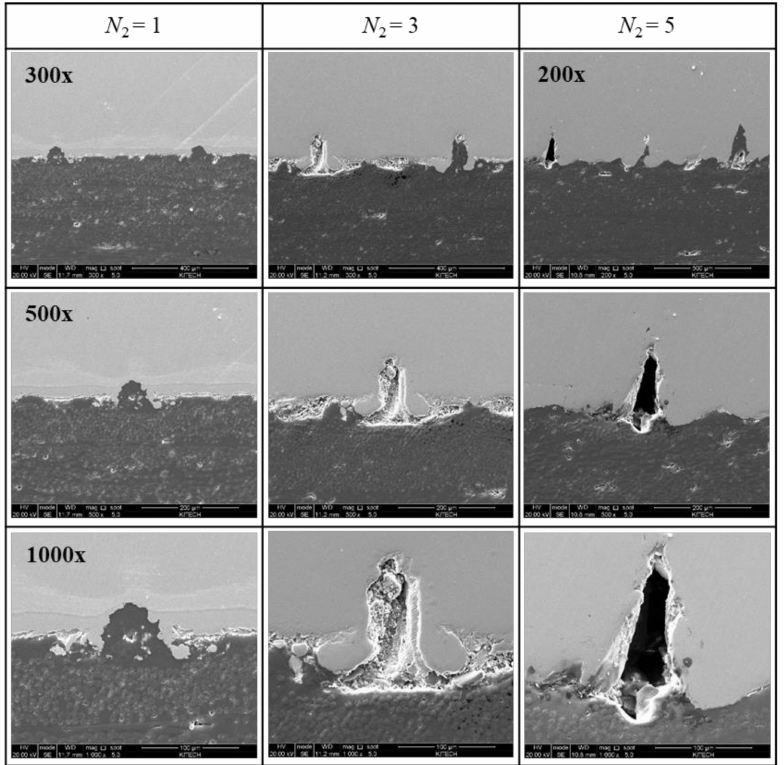
Figure 8. SEM images of the laser fusion cross-section of CFRP and galvanized steel w.r.t. the number of laser scans N 2 to form the pre-inscribed rectangular patterns. The parameters used for this bonding are: P 1 = 500 W, N 1 = 2, z 1 = 10 mm, d 1 = 5 mm, P c = 5 MPa, v 1 = 10 mm / min, P 2 = 45 W, N 2 = 1, v 2 = 200 mm / s, and z 2 = 0 mm, d 2 = 500